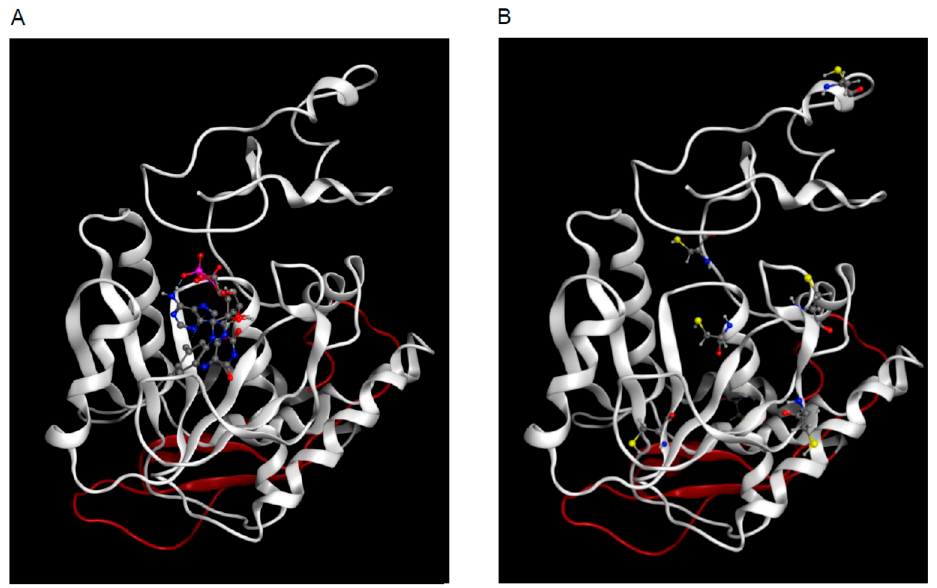
Figure 7. Three-dimensional (3D) model of hFADS6. Ribbon representation of hFADS6 modeled through Robetta as described in Materials and Methods. ( A ) FAD has been transferred in the active site from PDB ID: 3g6k and is represented in ball and stick. The PAPS reductase domain is colored in white, the N-terminus part of hFADS6 is colored in red. ( B ) Cys residues are represented in ball and stick and colored by elements. Element colors in ( A , B ): Sulfur, yellow; Nitrogen, blue; Oxygen, red; Phosphorus, pink; Carbon, grey.